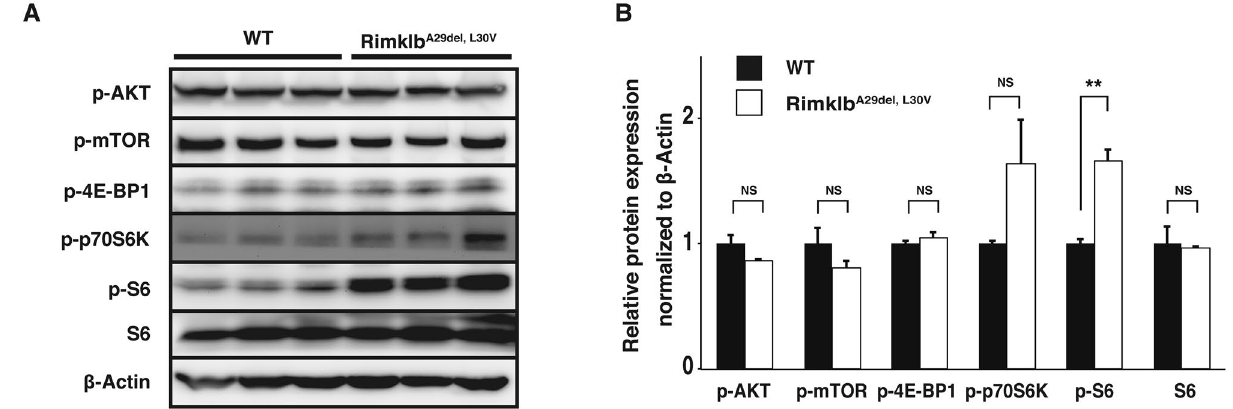
Figure 4. Hyperphosphorylation of ribosomal protein S6 in Rimklb A29del, L30V mouse testis. ( A ) Western blot analysis of p-AKT, p-mTOR, p-4E-BP1, p-p70S6K, p-S6 and S6 in WT and Rimklb A29del, L30V mouse testis at 12 weeks of age. β-Actin was used as a loading control except S6. Loading control of S6 was β-Actin as shown in Fig. 2D. ( B ) Graphic presentations show the expressions of p-AKT, p-mTOR, p-4E-BP1, p-p70S6K, p-S6 and S6. Data are presented as mean ± SEM; Student’s t-test; **p < 0.01, NS not significant. (n = 3).